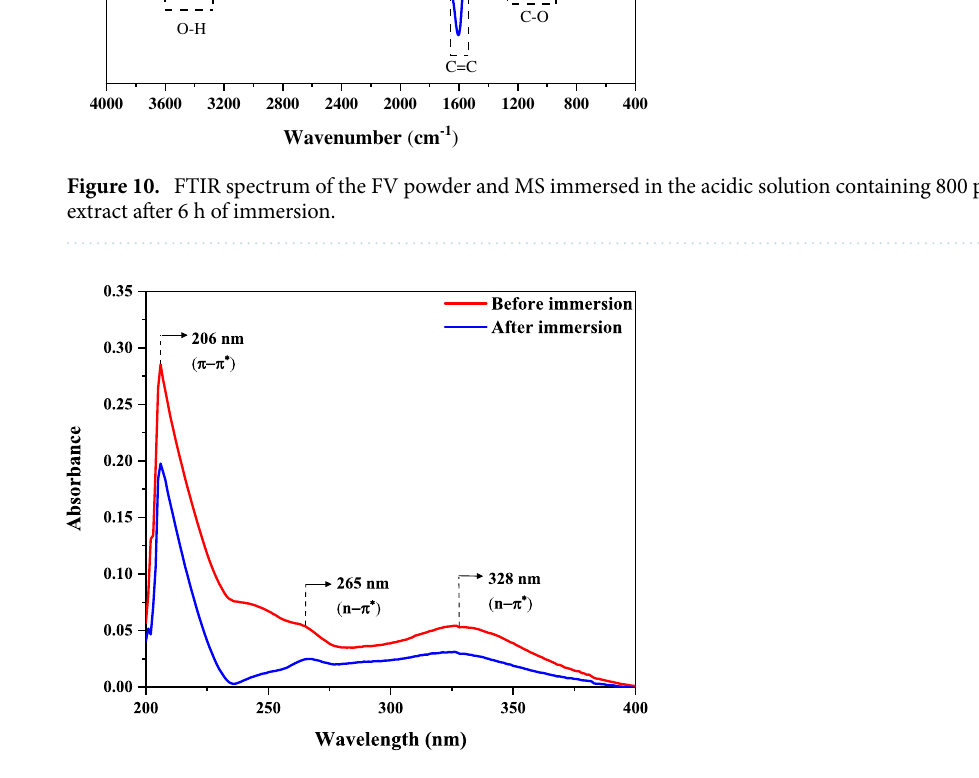
Figure 11. UV–Vis spectra of 1 M HCl solution containing 800 ppm FV extract before and after MS